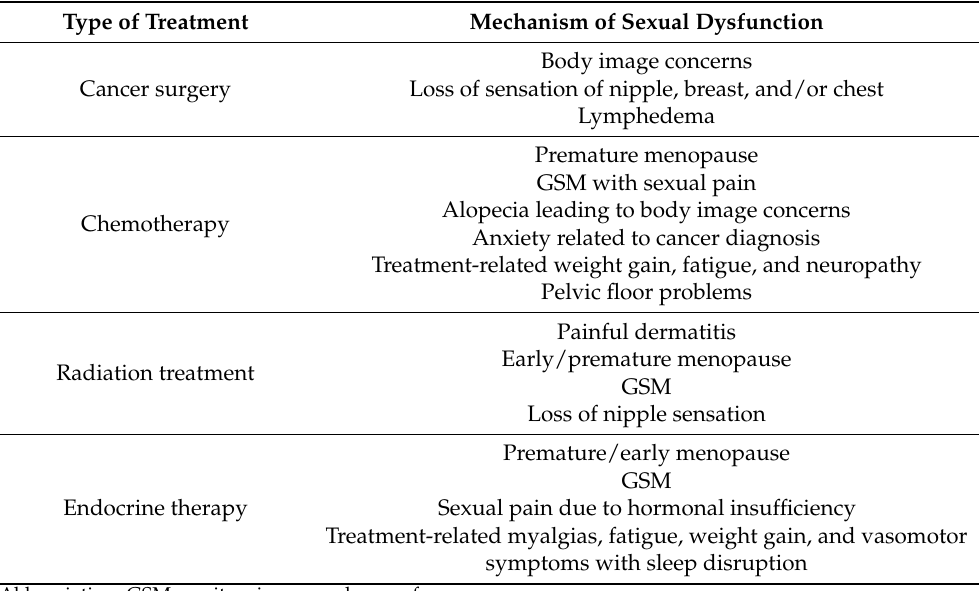
Table 1. Mechanisms Through Which Breast Cancer Treatments Can Influence Sexual Function. Type of Treatment Mechanism of Sexual Dysfunction Cancer